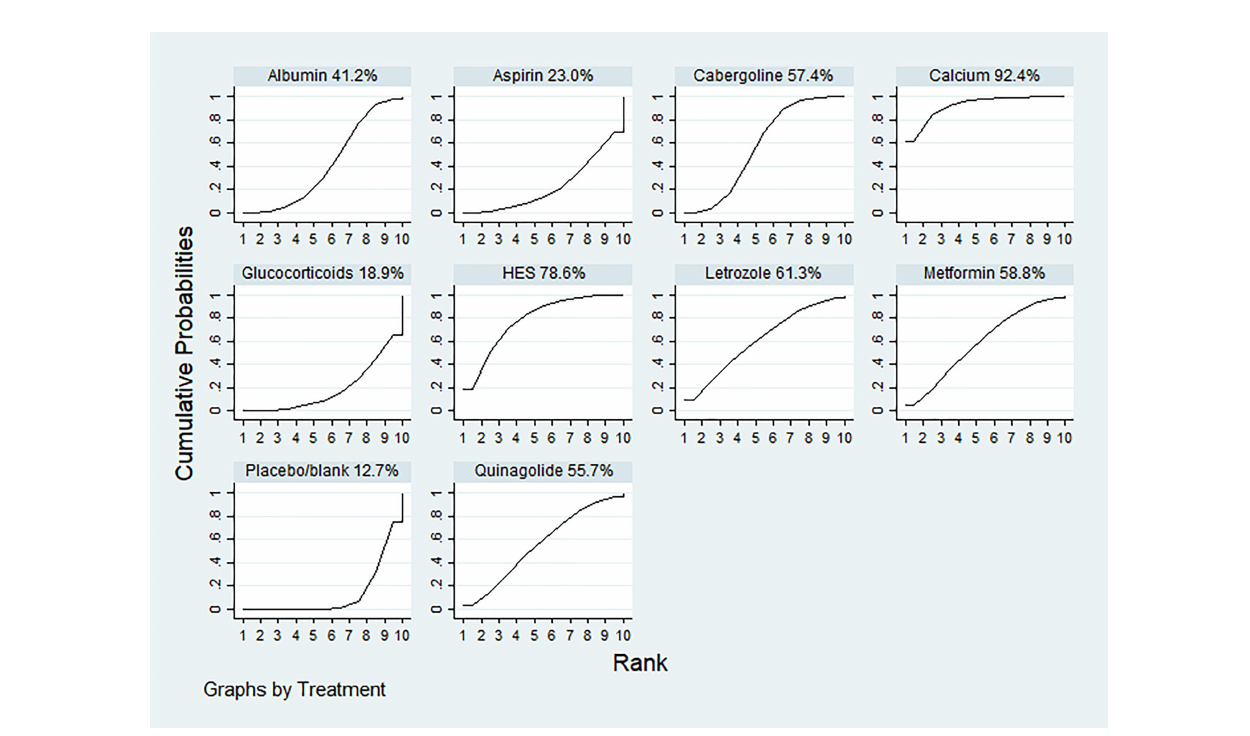
FIGURE 3 | The ranking of interventions for primary outcomes: the incidence rate of moderate-to-severe OHSS. The surface under the cumulative ranking curve values for calcium, hydroxyethyl starch (HES), letrozole, metformin, cabergoline, quinagolide, albumin, aspirin, glucocorticoids and placebo/blank was 92.4, 78.6,